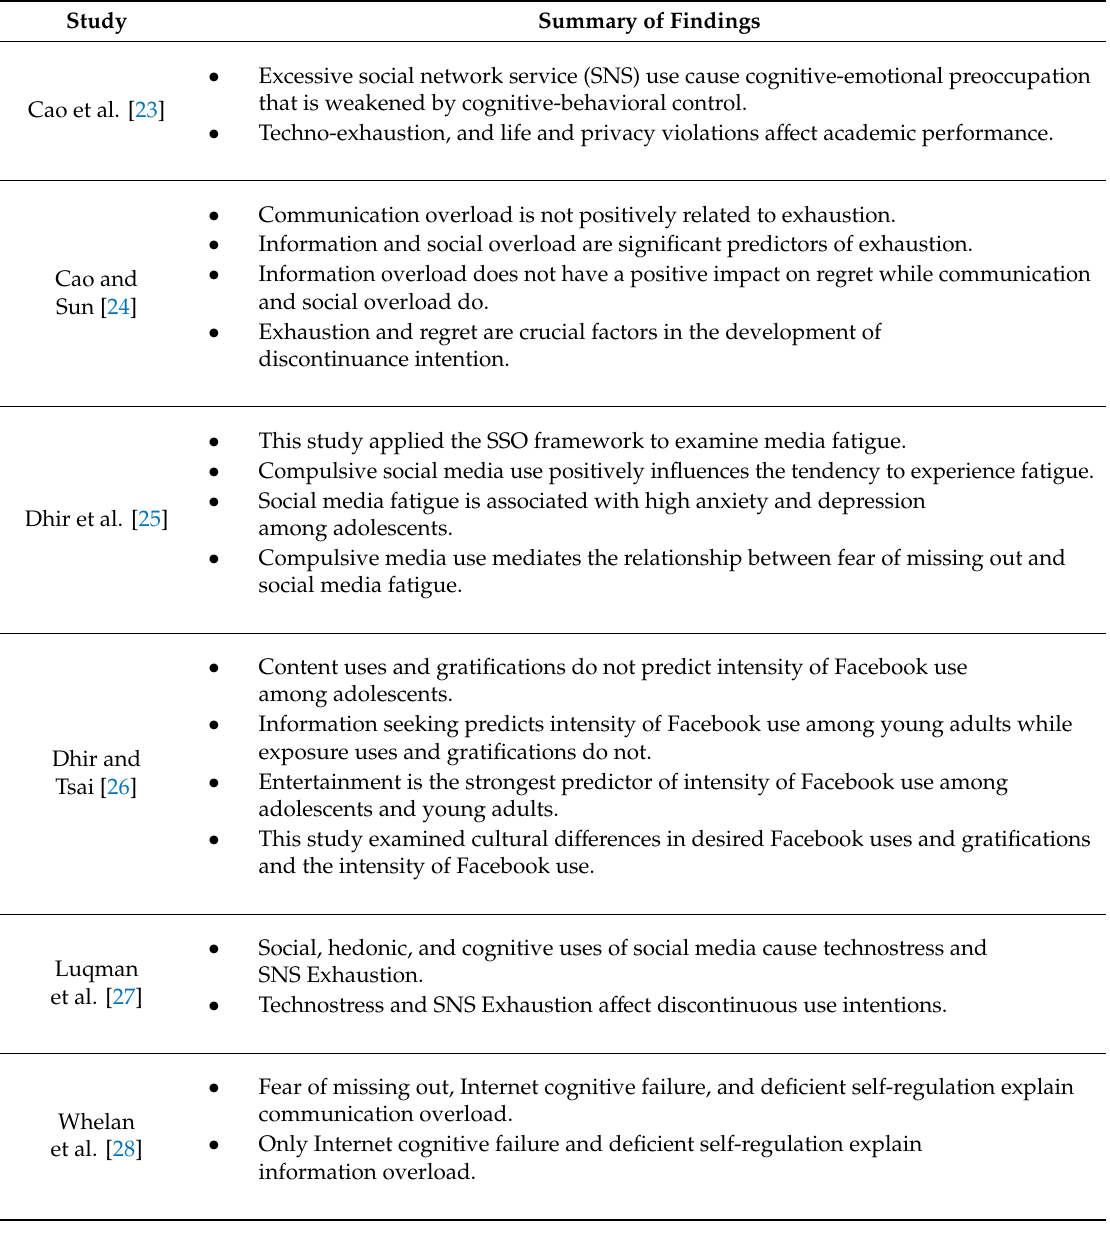
Table 1. Recent key studies regarding